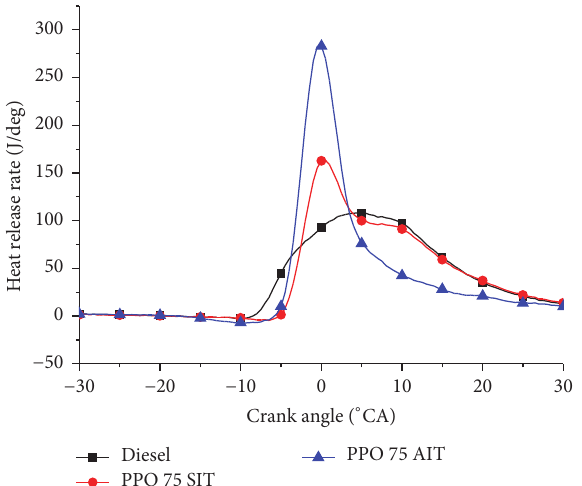
Figure 4: Variation of heat release rate with crank angle at 75% load.